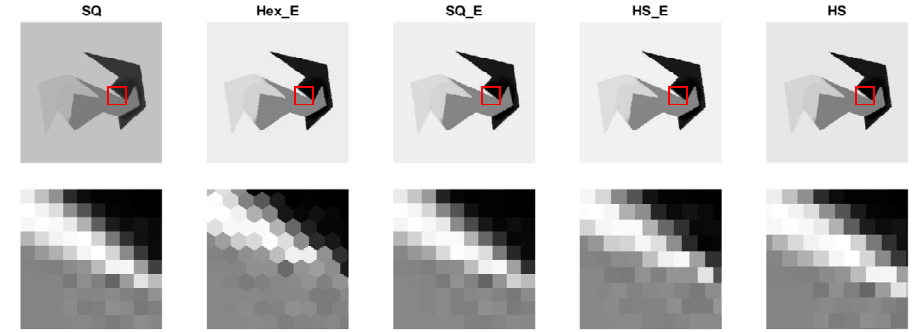
Figure 5. One of original images and its set of generated images.